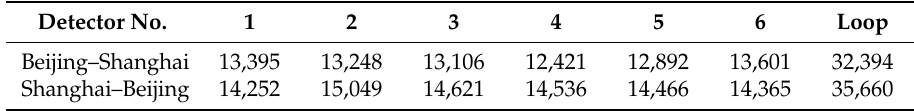
Table 4. Number of total distinct detected identifications for Internet of Things (IoT) detectors during the field